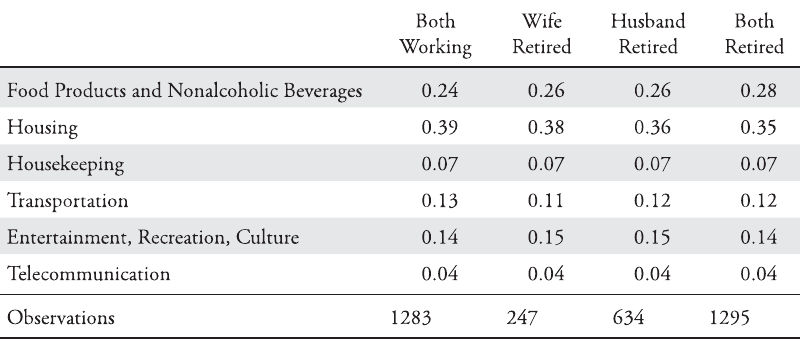
Table 3: Mean Budget Shares fur Couples by Retirement